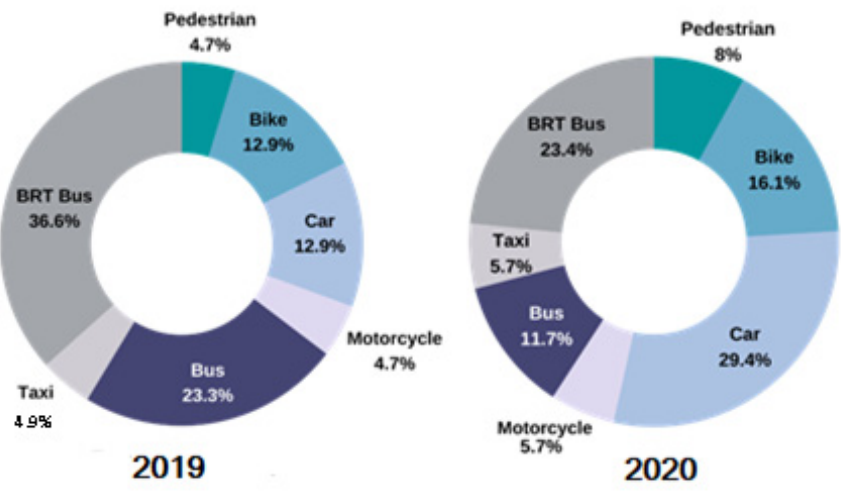
Figure 4. Transport modes in 2019 compared to 2020 or pandemic times according to the ITHACA perception survey.